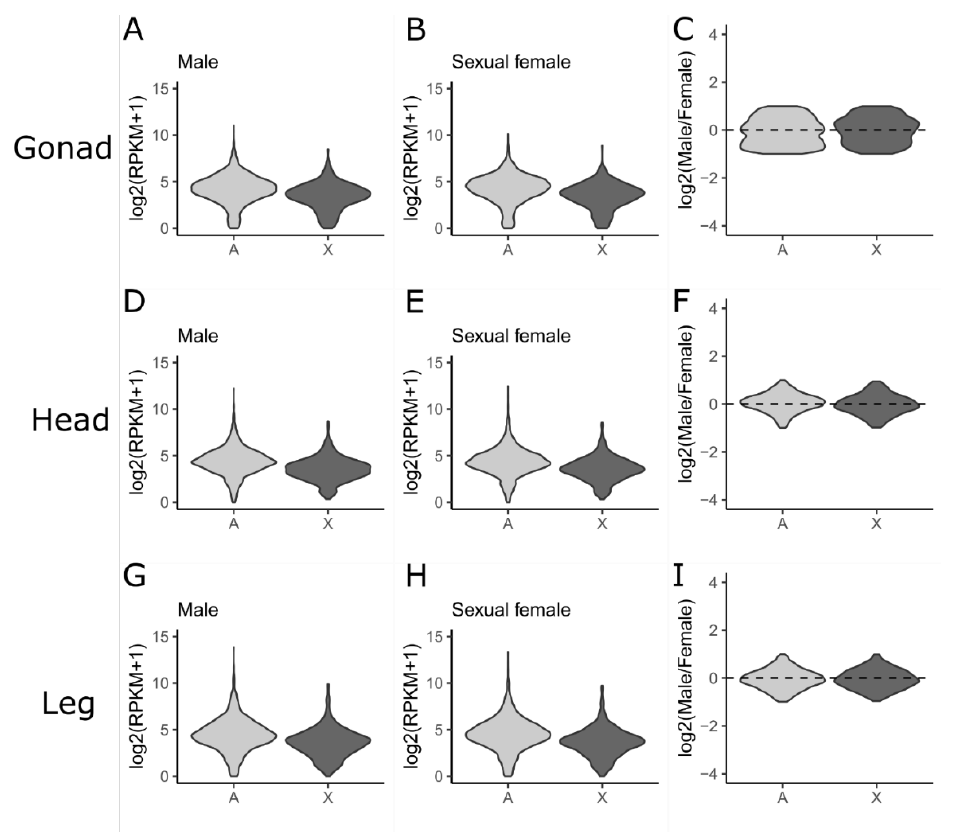
Supplementary figure S5: Logarithm of gene expression (RPKM+1) in males and sexual females for X- linked and autosomal genes in gonads (panels A and B), head (D, E) and legs (G, H). Only genes showing a less than 2-fold change in expression between males and sexual females within each of the tissues were retained. X-linked genes are significantly less expressed than autosomal genes in all cases (two-sided Mann-Whitney tests, p < 10 -15 ). Logarithm of male to parthenogenetic female ratio of RPKM is also shown for the three tissues (panels C, F and